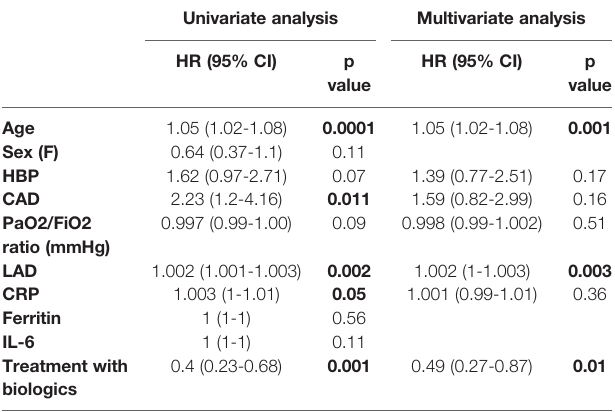
TABLE 5 | Baseline univariate and multivariate predictors of mortality in the patients ’ cohort.